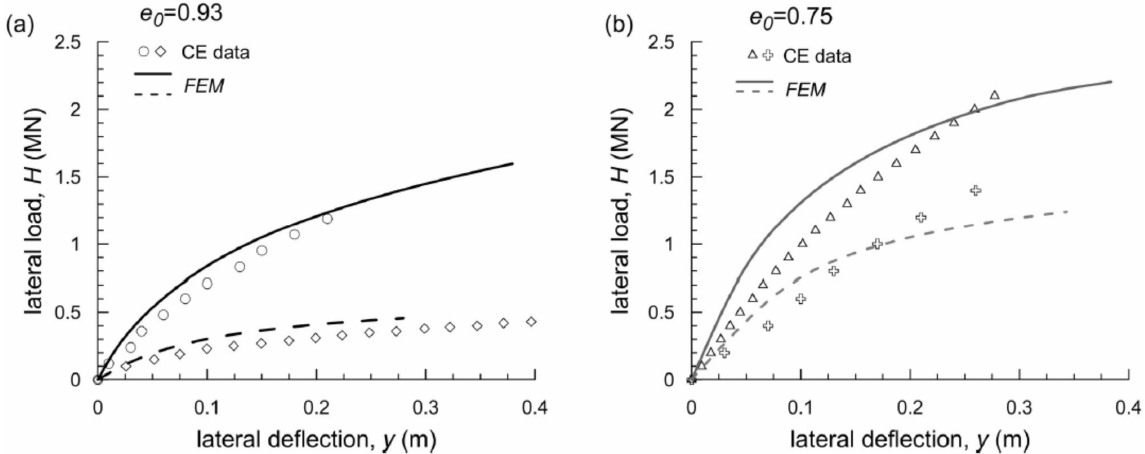
Figure 6. Load deflection curves predicted and measured: ( a ) loose soil, ( b ) dense